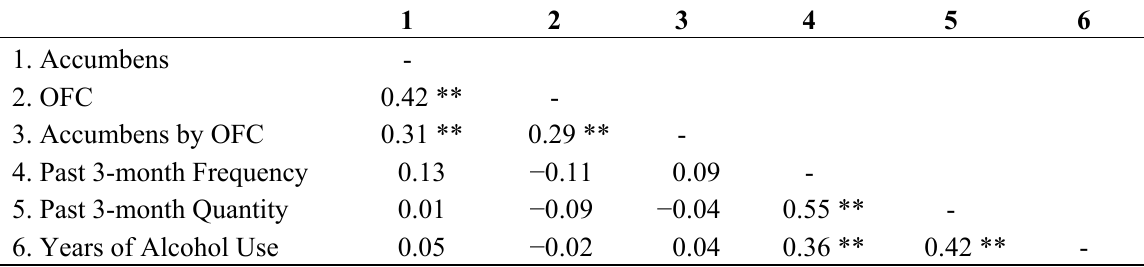
Table 1. Correlations between volumetric and alcohol